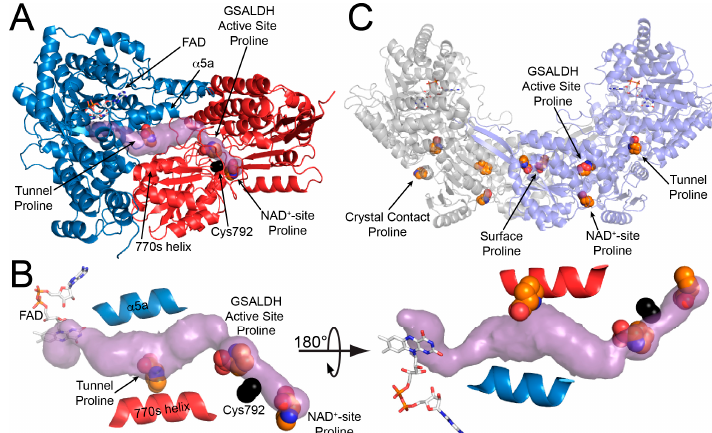
Figure 2. The crystal structure of BjPutA C792A. ( A ) The protomer of BjPutA C792A. The PRODH module is colored blue. The GSALDH module is colored red. The purple surface represents the substrate-channeling tunnel. For reference, the two α -helices that border the central section of the tunnel are noted ( α 5a, 770 s helix). ( B ) Close-up view of proline molecules bound in the GSALDH active site and the middle of the tunnel. ( C ) The dimer of BjPutA C792A. The two protomers are colored gray and slate. The 9 proline molecules bound to the dimer are shown in spheres.